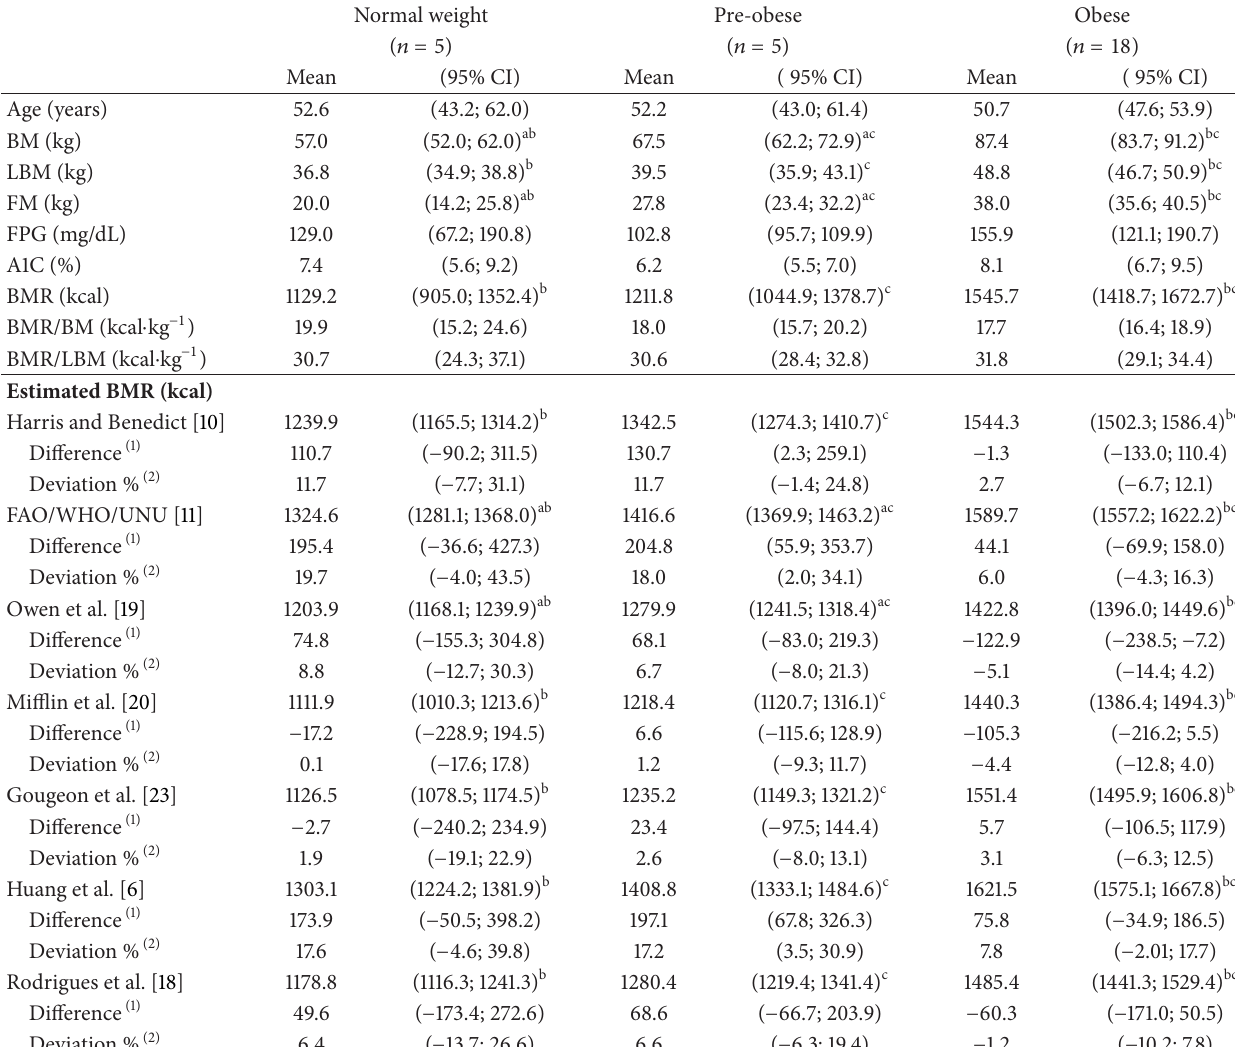
Table 4: Difference between the means of anthropometric, biochemical, and body composition of women with diabetes mellitus type 2 classified according to nutritional status